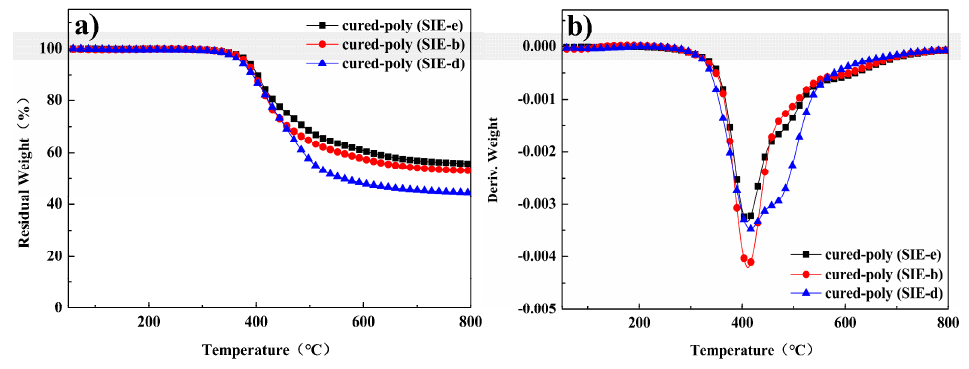
Figure 12. TGA curves for the bio-based cured benzoxazine polymers: ( a ) TG curves of the bio-based cured benzoxazine polymers; ( b ) DTG curves of the bio-based cured benzoxazine polymers. Table 2. DMA and TGA data of the cured MCBPs.